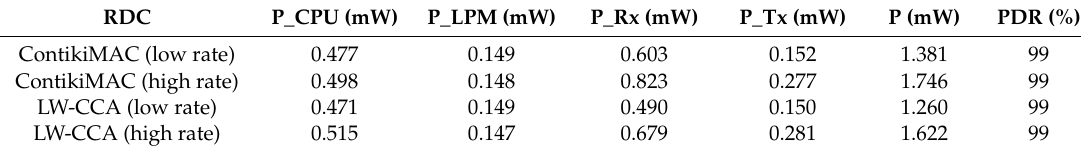
Table 10. Average of power consumption in CPU, LPM, Rx, Tx, total power consumption, and PDR.